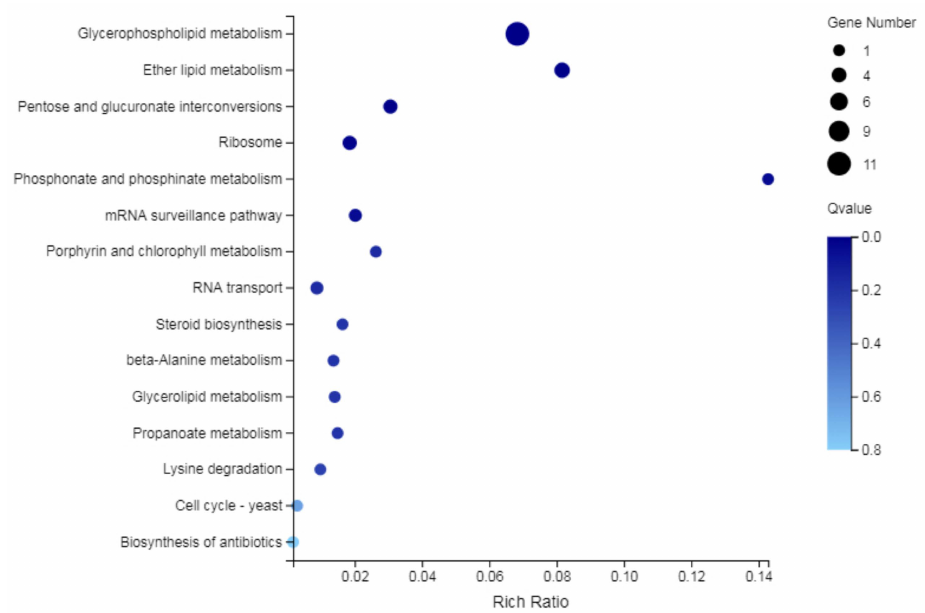
Figure 6. KEGG analysis of DEGs related to membrane and membrane components. Table 5. Key DEGs involved in phosphatidylserine decarboxylase and their primer sequences in qRT-PCR. Gene